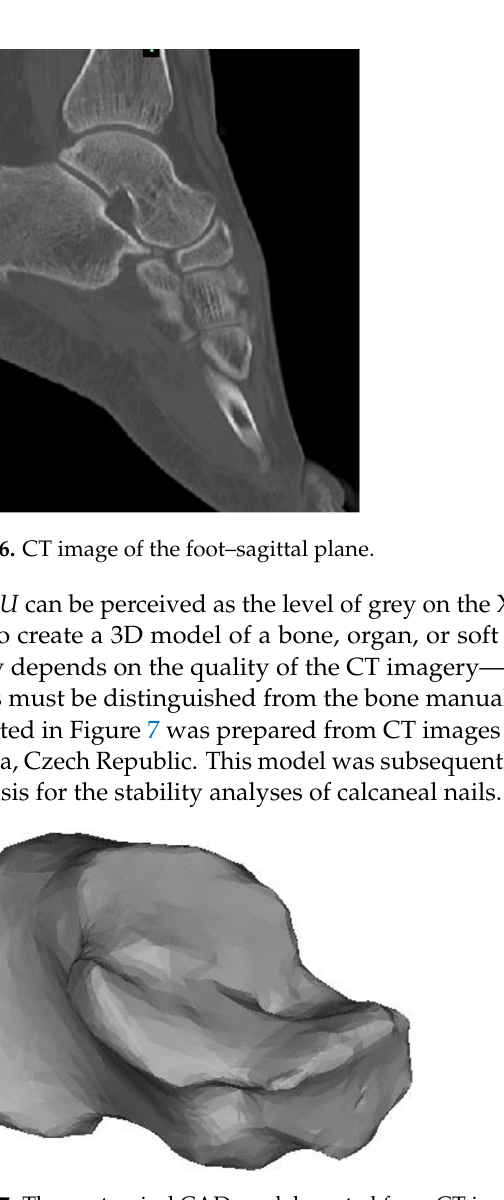
Figure 7. The anatomical CAD model created from CT imagery in the Mimics software.